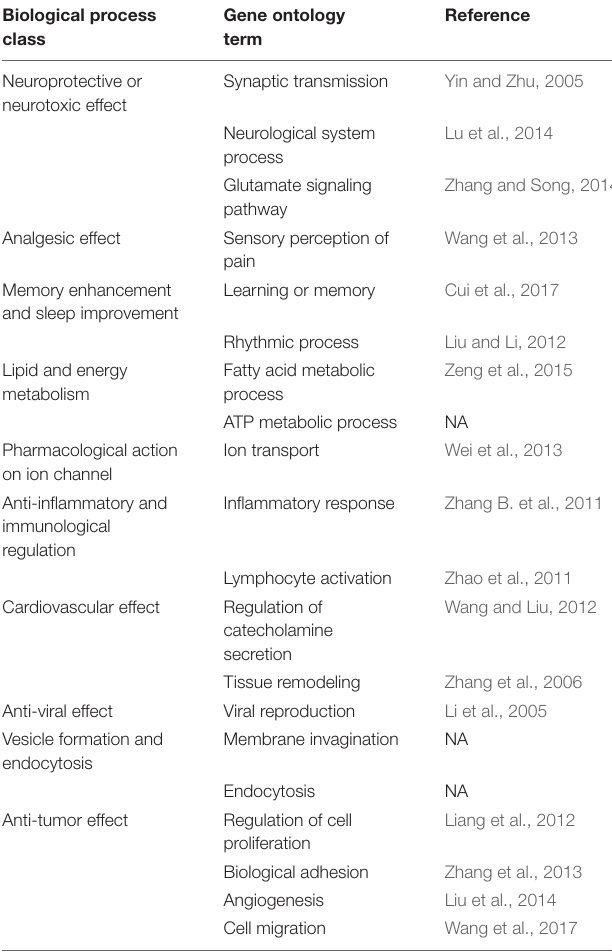
TABLE 1 | Enriched biological processes of predicted targets for